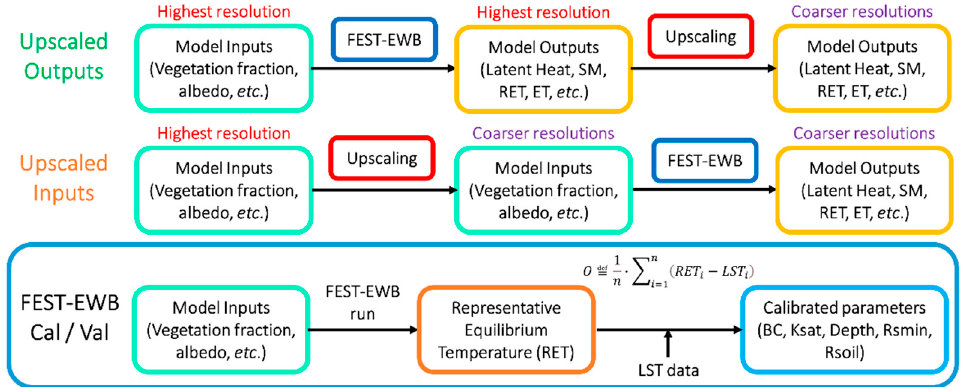
Figure 1. Flowchart of the two approaches compared in the scale analysis. The calibration/validation process for the FEST-EWB model is also detailed in the lowermost box.